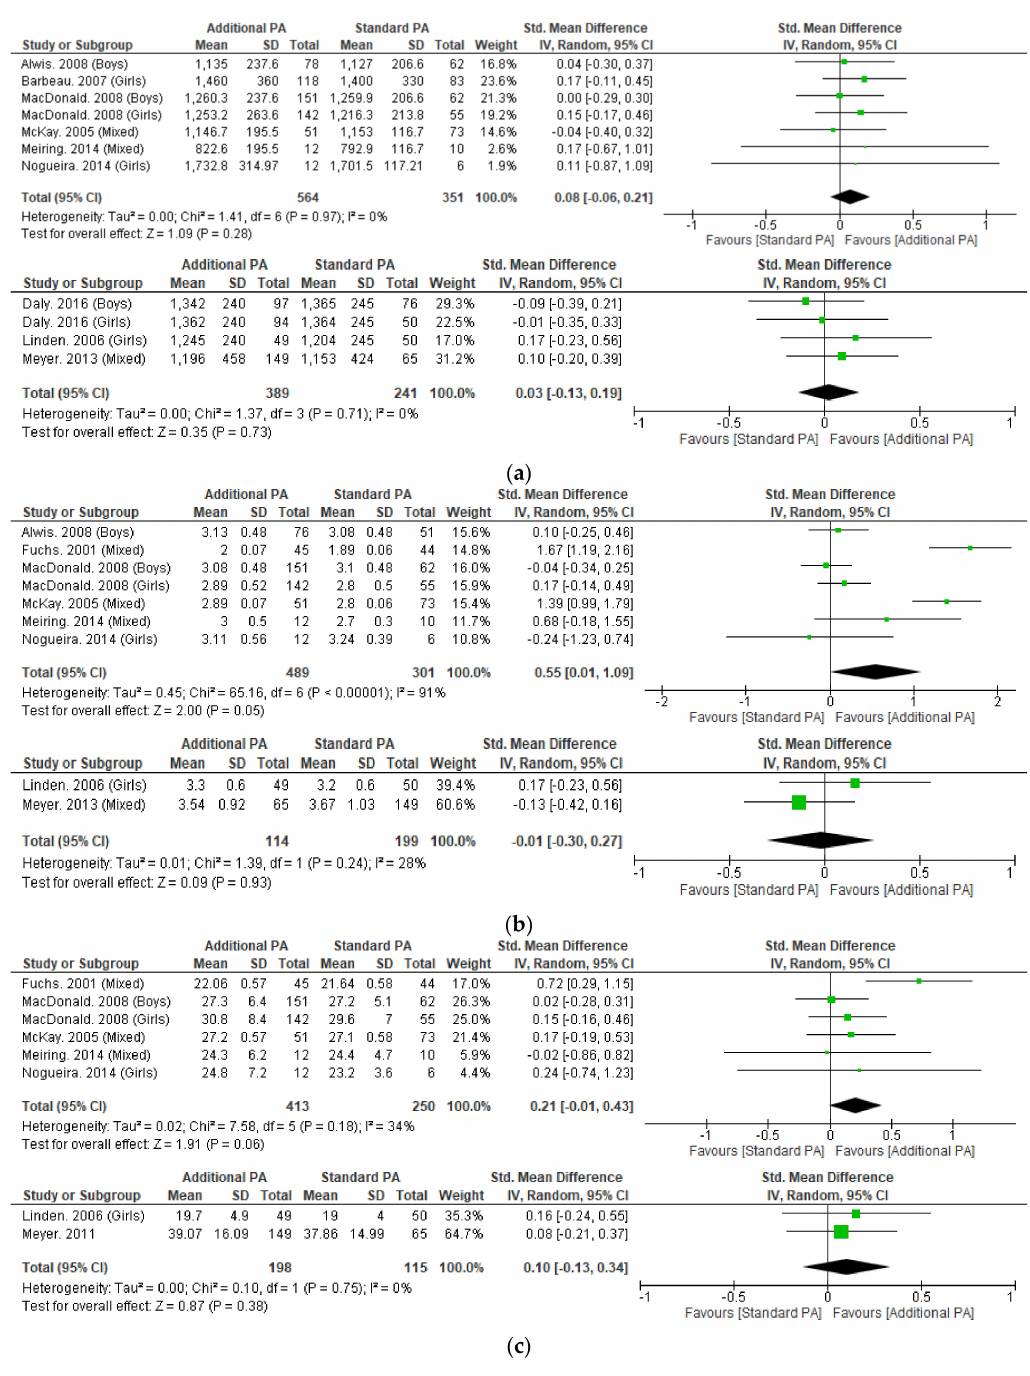
Figure 2. ( a ) Effect of additional exercise interventions on whole body bone mineral content. ( Top ) Less than 15 months follow-up, ( Bottom ) 24–48 months follow-up. Legend: PA = Physical Activity, Std = standardised, IV = inverse variance, SD- standard deviation, CI = confidence interval. ( b ) Effect of additional exercise interventions on femoral neck bone mineral content. ( Top ) Less than 15 months follow-up, ( Bottom ) 24–48 months follow-up. Legend: PA = Physical Activity, Std = standardised, IV = inverse variance, SD- standard deviation, CI = confidence interval. ( c ) Effect of additional exercise interventions on lumbar spine bone mineral content. ( Top ) Less than 15 months follow-up, ( Bottom ) 24–48 months follow-up. Legend: PA = Physical Activity, Std = standardised, IV = inverse variance, SD- standard deviation, CI = confidence